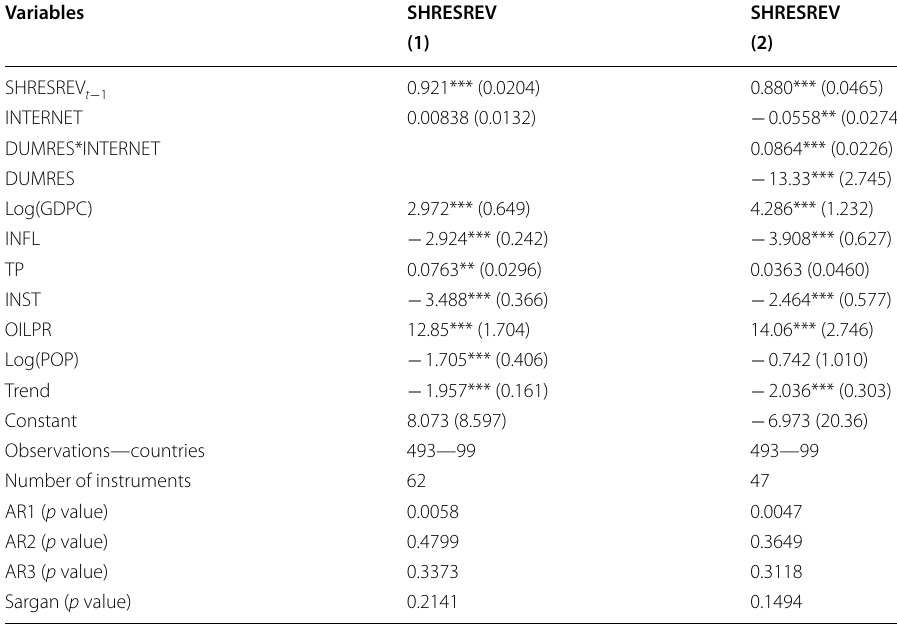
Table 2 Impact of the Internet usage intensity on the share (%) of resource revenue in total resource revenue. Estimator : Two-step system